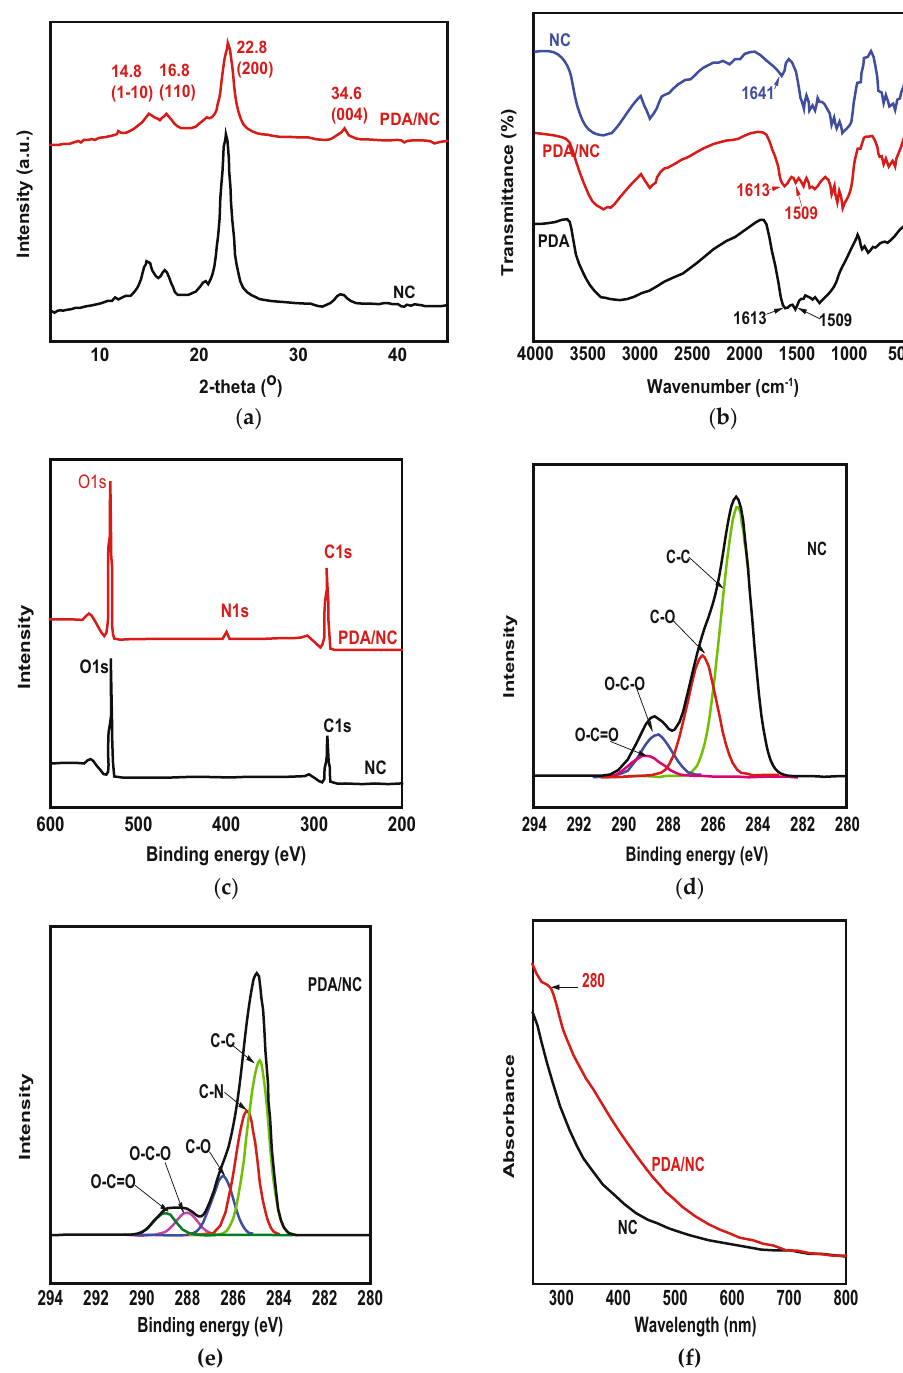
Figure 1: XRD ( a ) , FT - IR ( b ) , full - range XPS spectra ( c ) , for NC ( d ) , for PDA/NC ( e ) , and UV - vis spectra ( f ) of NC and PDA/NC